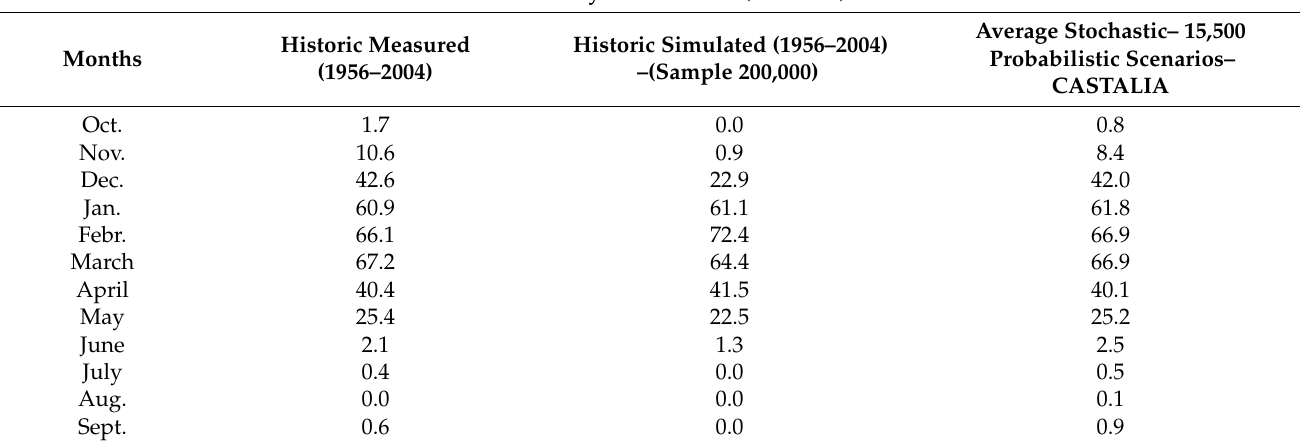
Table A4. Mean monthly excess water volumes ( × 10 6 m 3 ) as derived from (a) the historic measured runoff data (1956–2004), (b) 200,000 generated random sample from the historic simulated runoff data (1956–2004) and (c) the 15,500 probabilistic scenarios (using